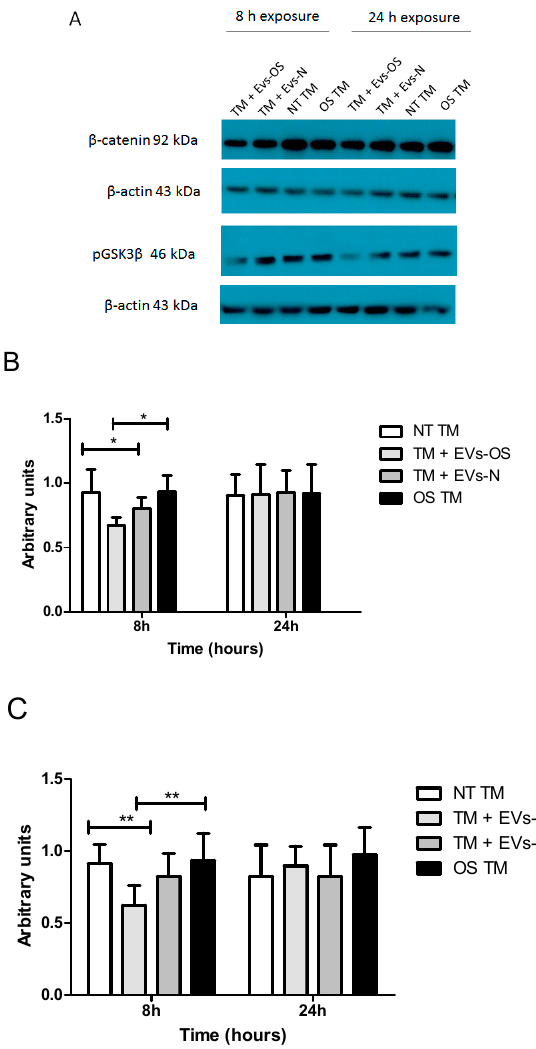
Figure 6. Wnt protein expression under normal or stress conditions following exposure to NPCE-derived EVs. Protein expression levels of β -catenin and p-GSK3 β in TM cells under the treatment of NPCE exosomes. ( A ) Representative Western blots showing protein expression of β -catenin and p-GSK3 β in cell lysates from TM cells treated with NPCE stressed or normal exosomes for 8, 24 h, or 15 mM AAPH for 1.5 h. Quantification of ( B ) β -catenin and ( C ) p-GSK3 β protein levels from three